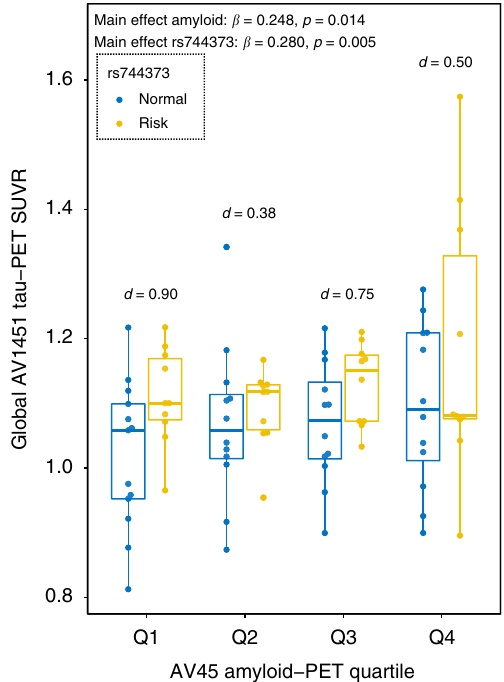
Fig. 3 BIN1 rs744373 effects on tau across the amyloid spectrum. Boxplot showing the association between BIN1 rs744373 (risk-allele n = 40, yellow; normal-allele n = 49, blue) and global AV1451 tau-PET uptake across amyloid quartiles. The statistical main effects presented in the upper left corner of the graph are derived from linear regression, with the BIN1 rs7443733 SNP and global AV45 amyloid-PET SUVR as predictors, controlling for age, gender, diagnosis, and ApoE ε 4 status. Cohens d effects sizes displayed in the plot were derived for each quartile. Note, that no interaction between BIN1 rs744373 and global AV45 amyloid-PET uptake was found, suggesting that the effects of BIN1 rs744373 on tau are similar between high- and low-amyloid groups. Boxplots are displayed as median (center line) ±interquartile range (box boundaries) with whiskers including observations falling within the 1.5 interquartile